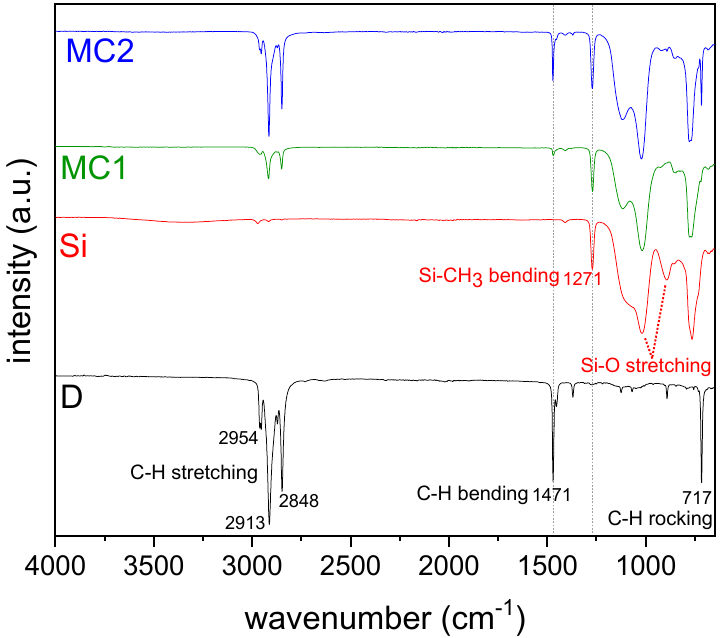
Figure 3. FTIR spectra of the bulk docosane (D), docosane-organosilica core-shell microparticles (MC1 and MC2) and the neat organosilica microparticles (Si).